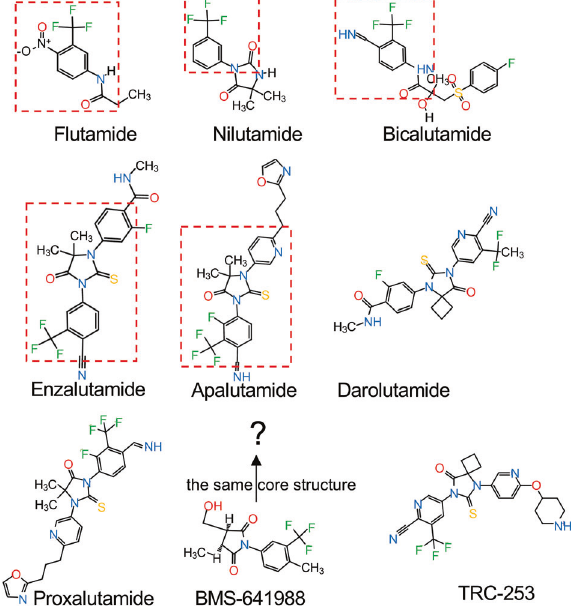
Fig. 1 The 2D structure of AR antagonists. The red dotted box indicates the shared structure between drugs. Drug structure resources from